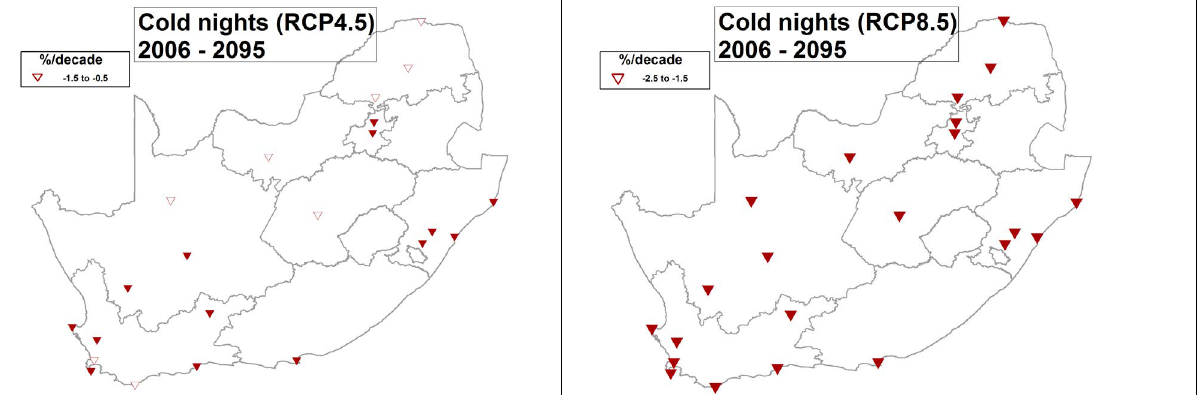
Trends in annual number of cold nights (TN10P) in % per decade, for the period 2006–2095 for the RCP4.5 and RCP8.5 scenarios, as indicated. Filled triangles denote significant trends at the 5% level.